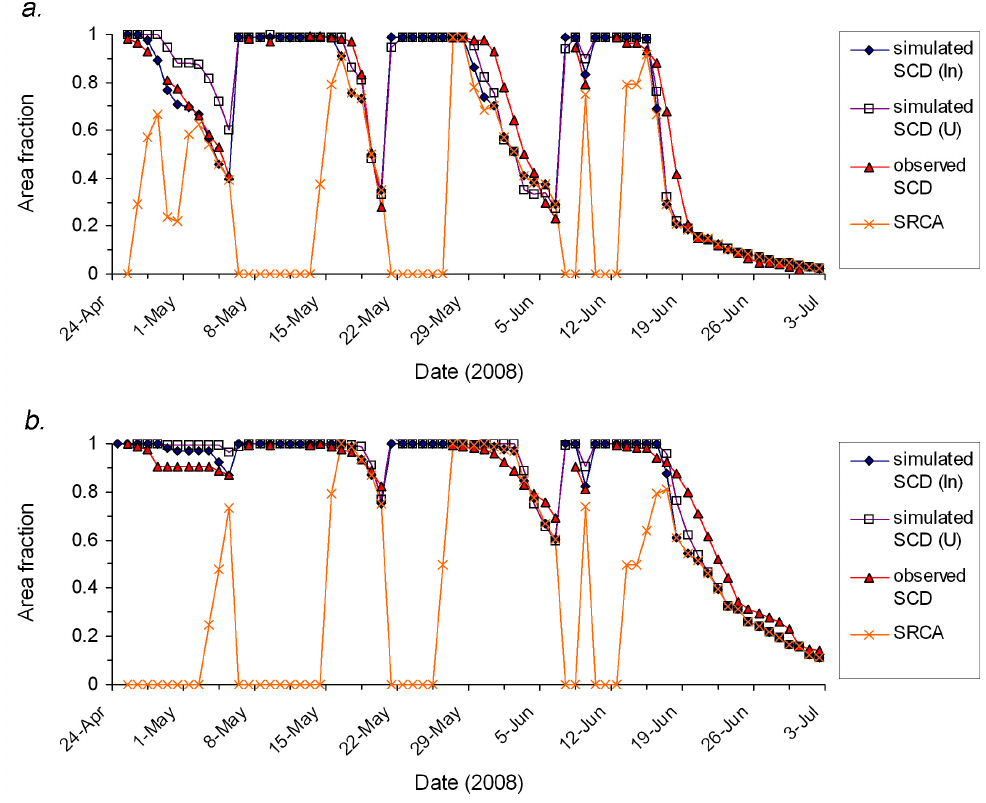
Fig. 6. Simulated vs. observed SCD curves and the SRCA over the entire spring period within the Mt. Allan cirque in 2008: (a) South-facing slope unit; (b) North-facing slope unit. SCD curves were derived based on inhomogeneous melt (In), and from uniform slope-based melt (U) as in Fig. 5.